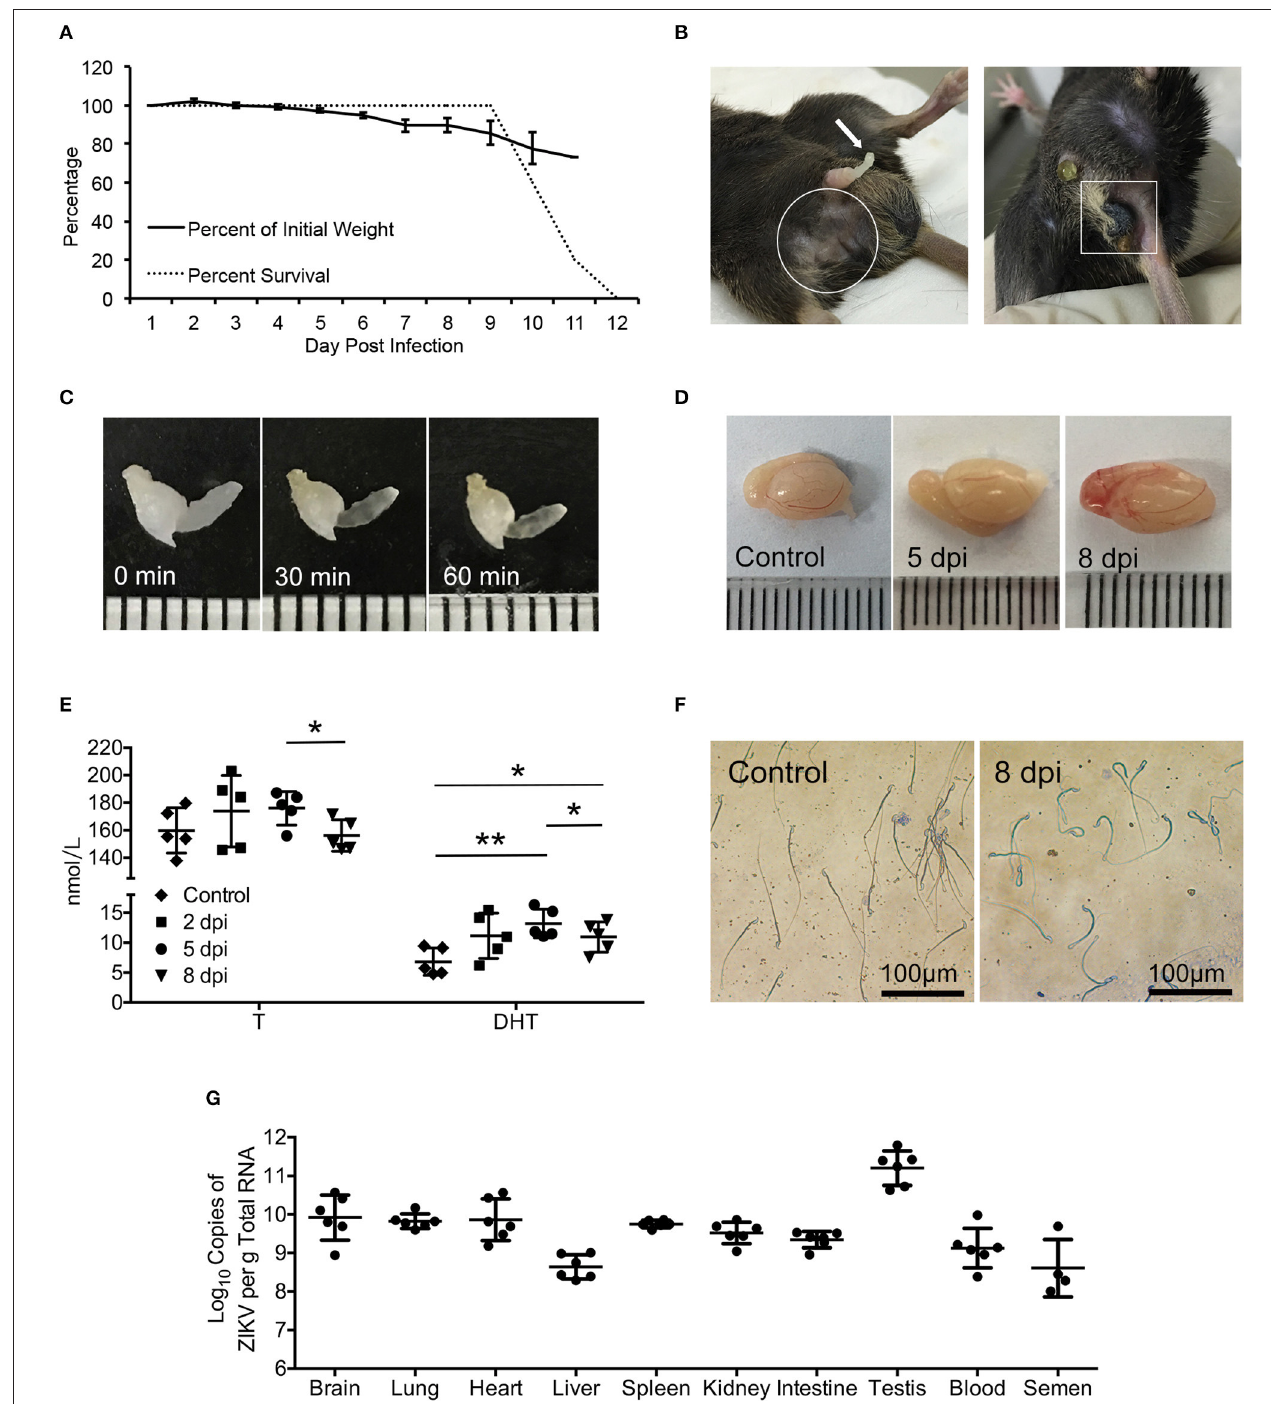
FIGURE 1 | Signs of the disease, changes of serum androgen level and morphology of sperms as well as the virus detection in ZIKV-infected AG6 mice. (A) Changes of body weights and survival rate post infected with 10 5 pfu ZIKV in male AG6 mice ( n = 5). (B) Clinical signs of reproductive system disorder were observed in male ZIKV-infected mice. Spermatorrhea (left, arrow), trichomadesis (left, in frame), and necrosis of scrotum (right, in frame). (C) Semen harvested from mice with spermatorrhea at 8 dpi was incubated at 37 ◦ C for 30 and 60 min, showing non-liquefied semen. (D) Representative image of testis dissected from control and ZIKV-infected mouse at indicated time points. (E) Changes of testosterone (T) and dihydrotestosterone (DHT) levels in serum at indicated time points after ZIKV infection. Data are represented as mean ± SD (*, p < 0.05; **, p < 0.01) ( n = 5). (F) Morphology of sperms from ZIKV-infected mice at 8 dpi or control mice revealed by Papanicolaou staining. (G) Viral load determined by qRT-PCR in organs, serum and semen at 5 dpi. The standard curve was set up based on ZIKV RNA transcribed in vitro ( n = 4–6).